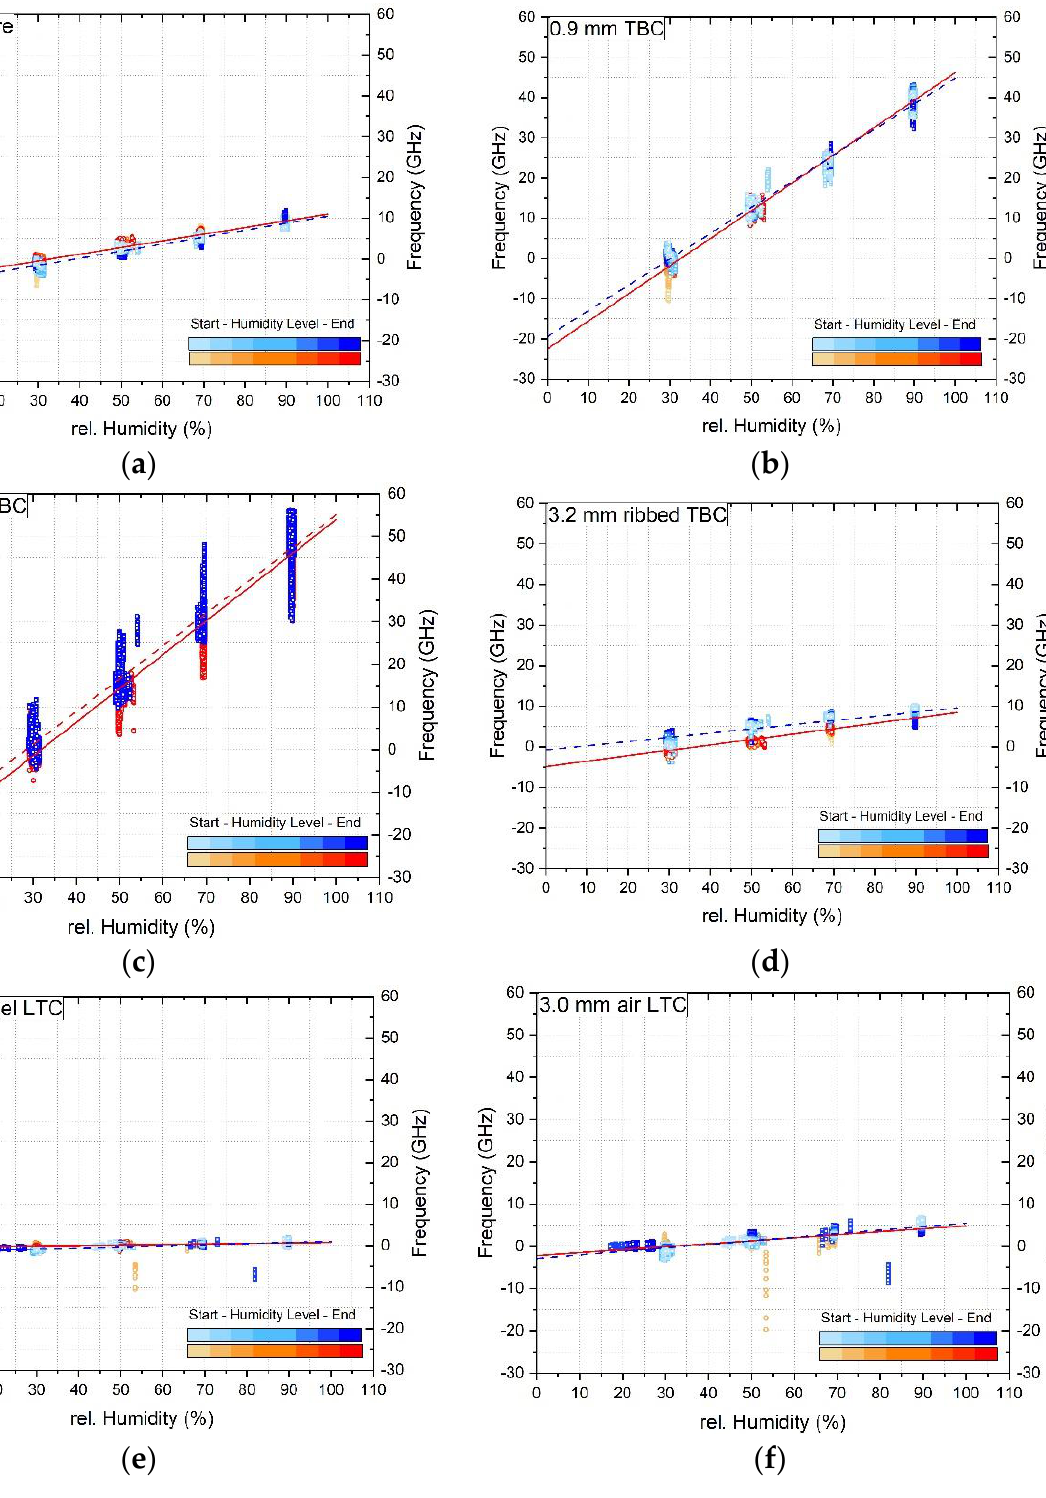
Figure 7. Increasing and decreasing humidity calibration datapoints and linear fit of ( a ) bare fibre, ( b ) 0.9 mm tight buffered, ( c ) 2.0 mm tight buffered, ( d ) 3.2 mm ribbed tight buffered, ( e ) 3.8 mm gel filled loose tube and ( f ) 3.0 mm air filled loose tube cable. The red line represents the increasing, the blue line the decreasing humidity level. The lighter colours refer to datapoints at the beginning (zero hours) whereas the darker colours indicate points as the end (30 h) of each humidity level.